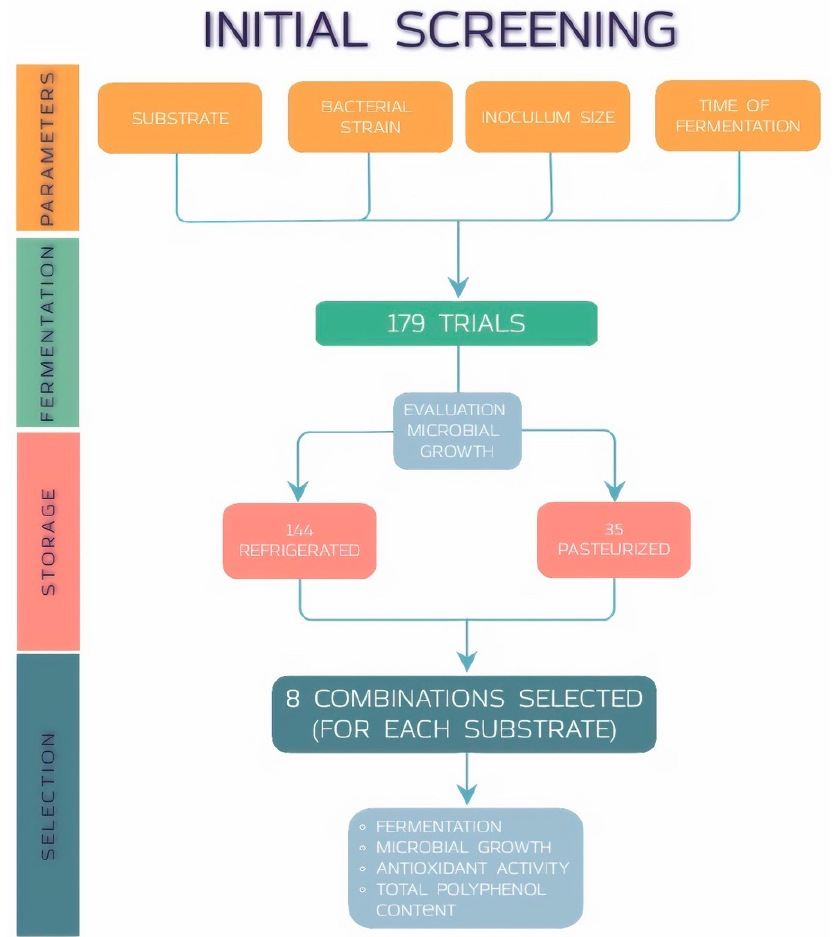
Figure 1. Design of fermentation conditions preliminary